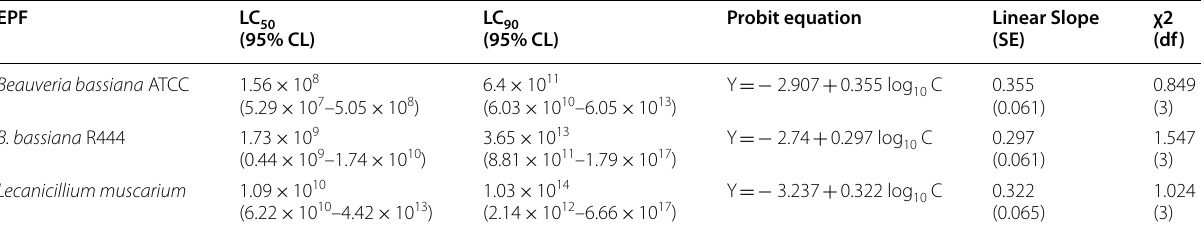
Table 2 Probit analysis, 7 days after treatment with Beauveria bassiana ATCC, B. bassiana R444 and Lecanicillium muscarium against T. absoluta eggs